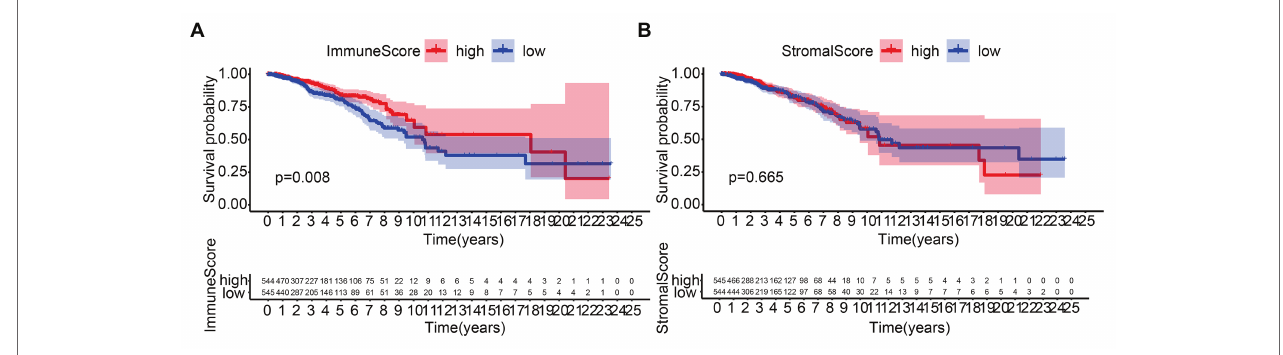
FIGURE 1 | Correlation of scores with the survival of patients with breast cancer (BC). (A) Kaplan–Meier (KM) survival analysis for BC patients grouped into the high or low score in ImmuneScore determined by comparing the median. (B) Kaplan–Meier survival curve for